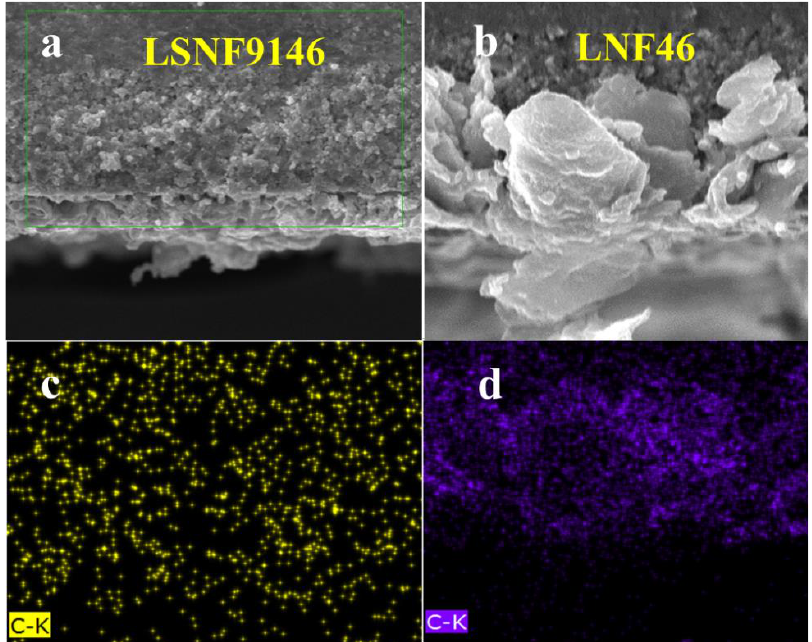
Figure 8. Anode cross-sectional SEM images of ( a ) SSZ-infiltrated LSNF9146 composite electrode and ( b ) SSZ-infiltrated LNF46 composite electrode after tests; Corresponding EDS elemental distribution of C ( c ) in LSNF9146 electrode and ( d ) in LNF46 composite electrode.